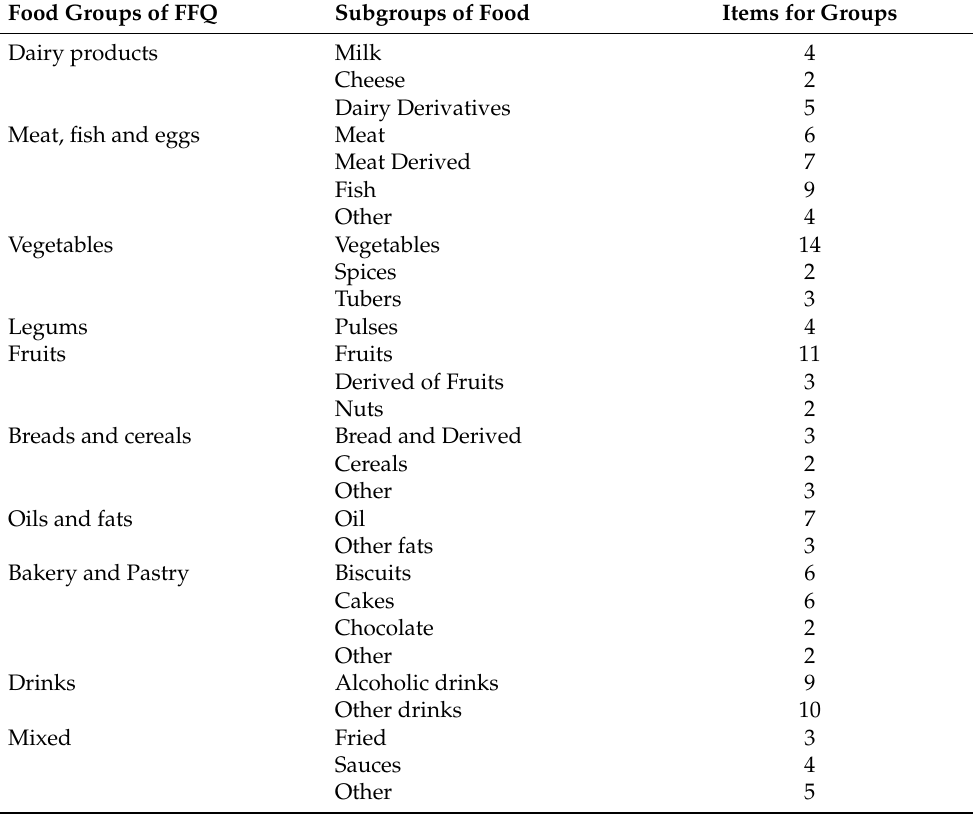
Table 1. Structure of the FFQ separated by groups, subgroups and number of